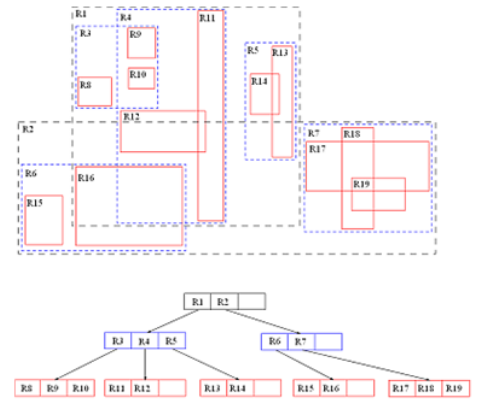
Figure 2. R-trees partition space based on bounding rectangles/boxes